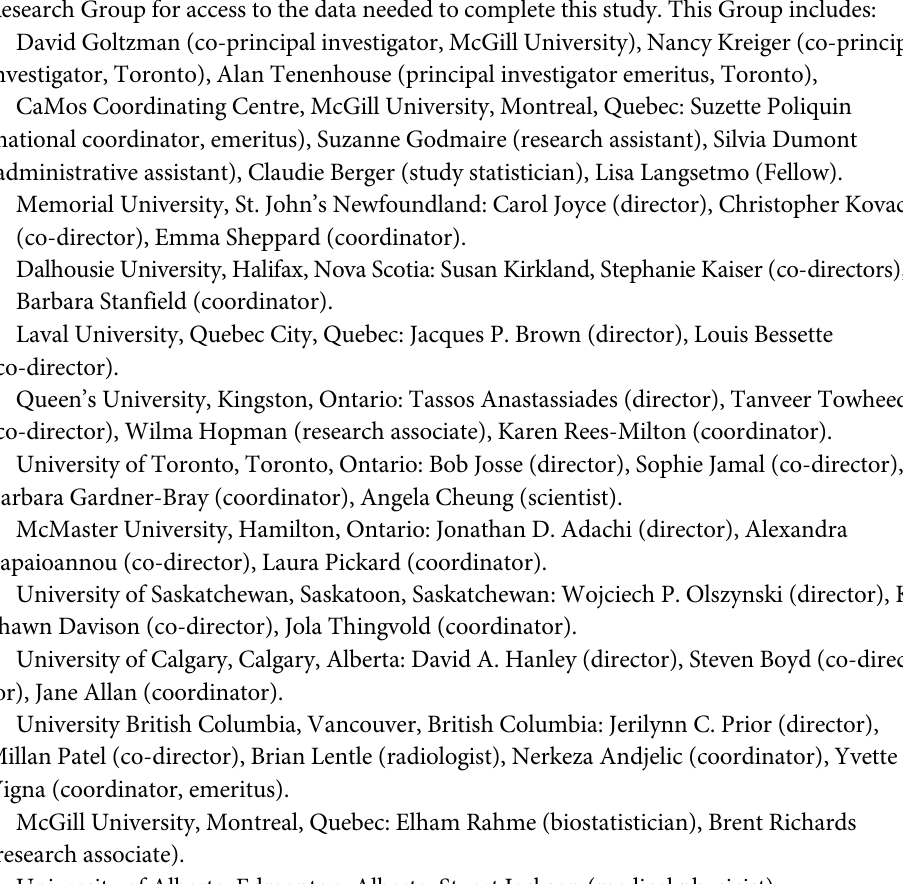
S1 Table. Percentages of respondents for the category “ Limited a lot ” on the PF sub-scale items by demographic and health status variables in the Canadian Multicentre Osteoporo- sis Study ( n = 9062). S2 Table. Percentages of respondents for the category “ All/most/good bit of the time ” on the MH sub-scale items by demographic and health status variables in the Canadian Multi- centre Osteoporosis Study ( n = 9115). S3 Table. Factor loading and item threshold estimates of the differential item functioning (DIF) model for the SF-36 physical functioning and mental health sub-scale items in the Canadian Multicentre Osteoporosis